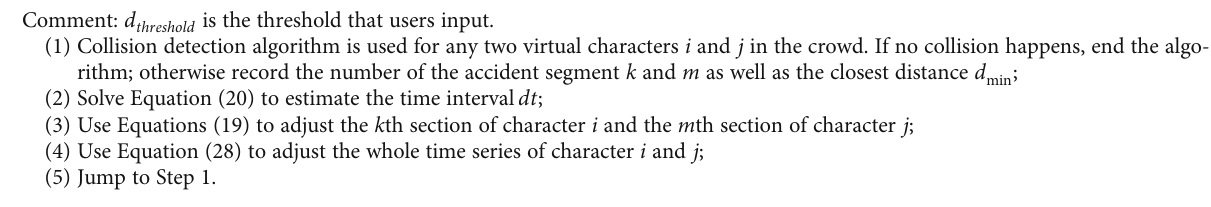
Algorithm 3: Time trajectory deformation algorithm.